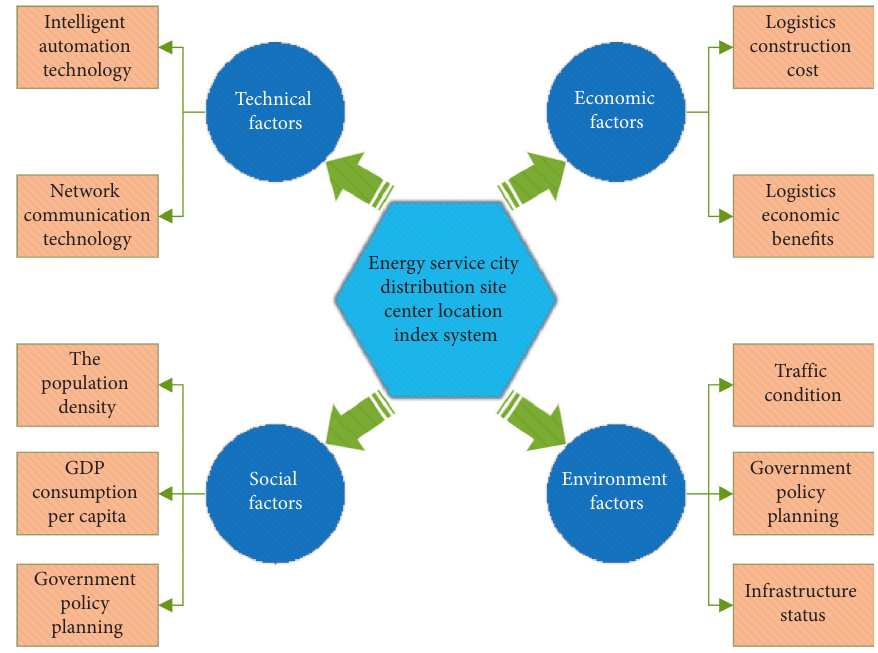
Figure 1: Energy service city distribution site center location index structure diagram.